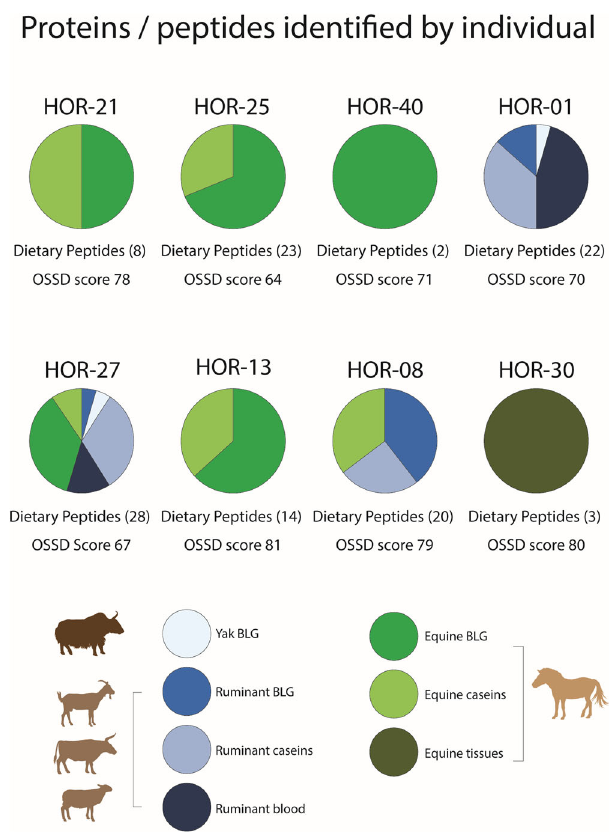
Fig. 4 Proportion of proteins/peptides for each individual. Each individual had varying proportions of dietary peptides found in their dental calculus, which was related to type of food and species of animal